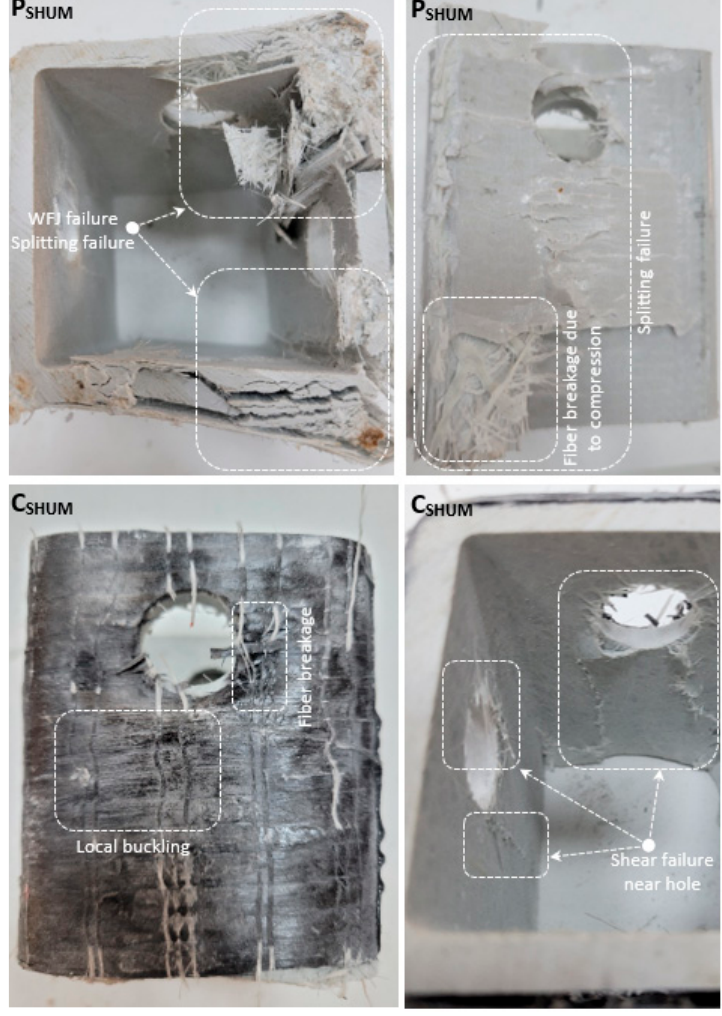
Figure 7. Damage analyses of P SHUM , C SHUM , G SHUM .